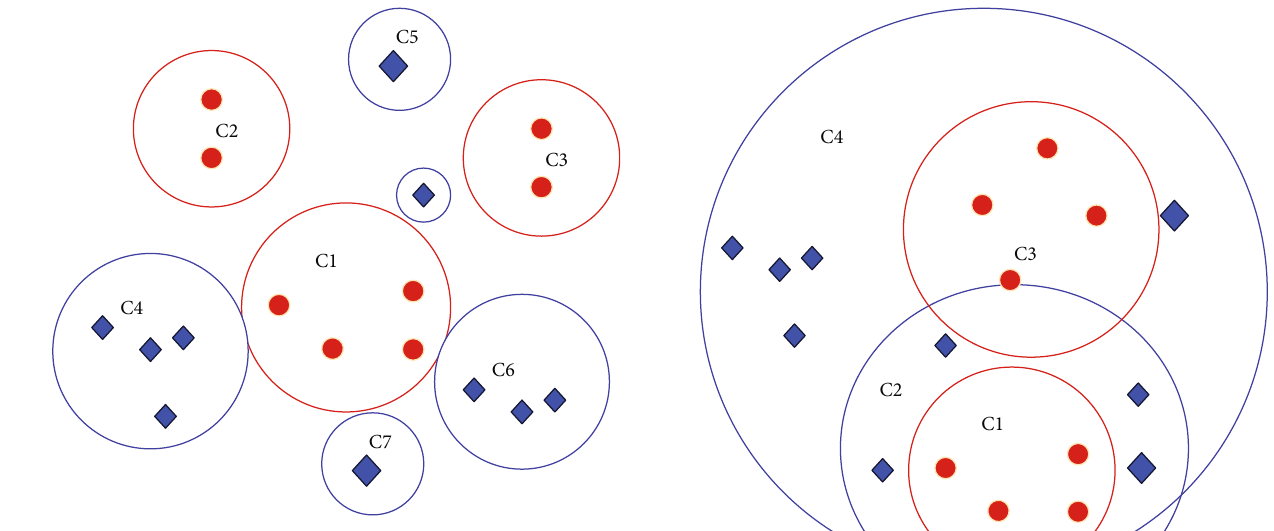
Figure 2: Classi fi cation results of the domain copula function.